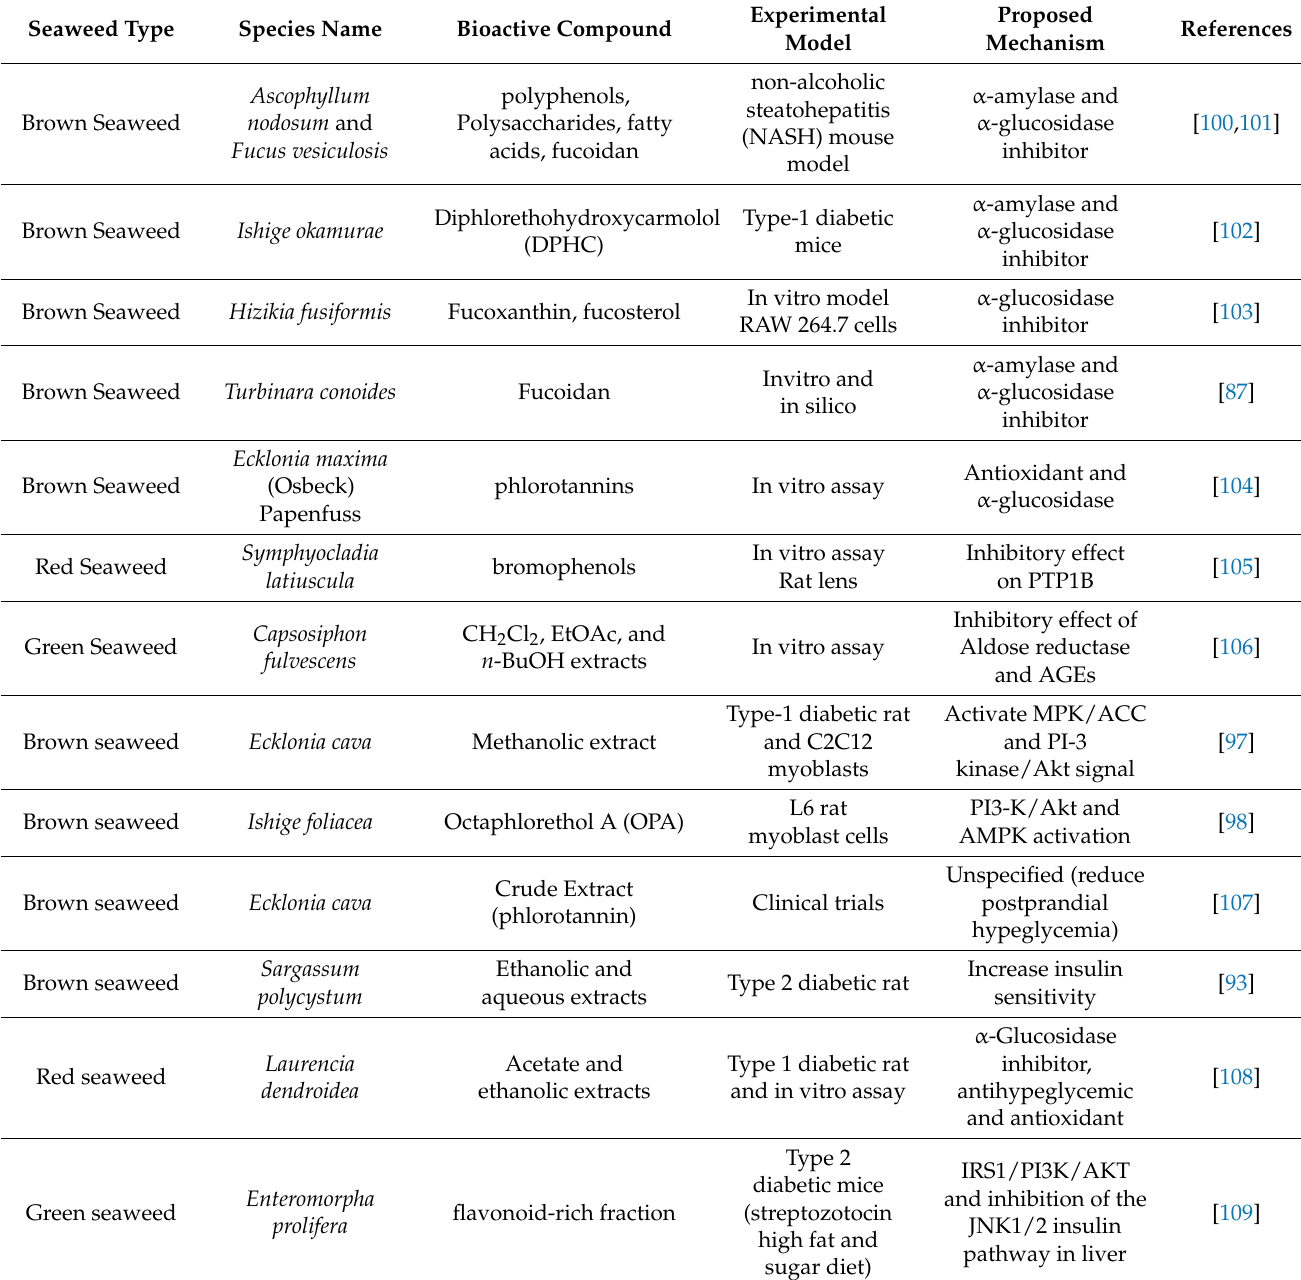
Table 2. Anti-diabetic bioactive compounds in seaweed as demonstrated in animal models with proposed mechanisms of